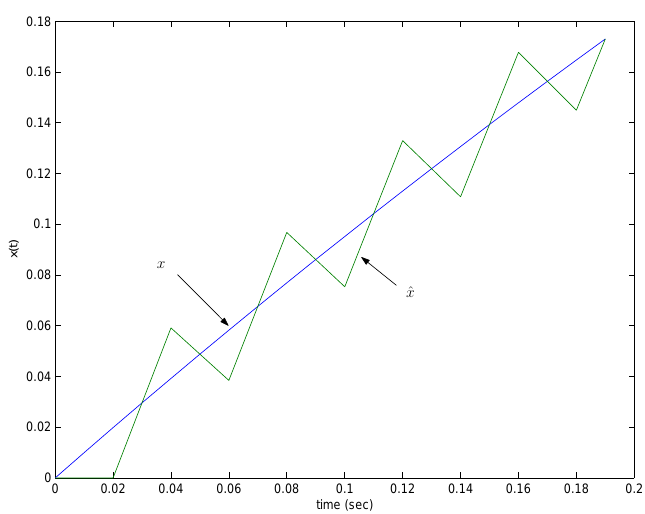
( t ) with δ = 0 . 02 ) is transmitted ( x k 1